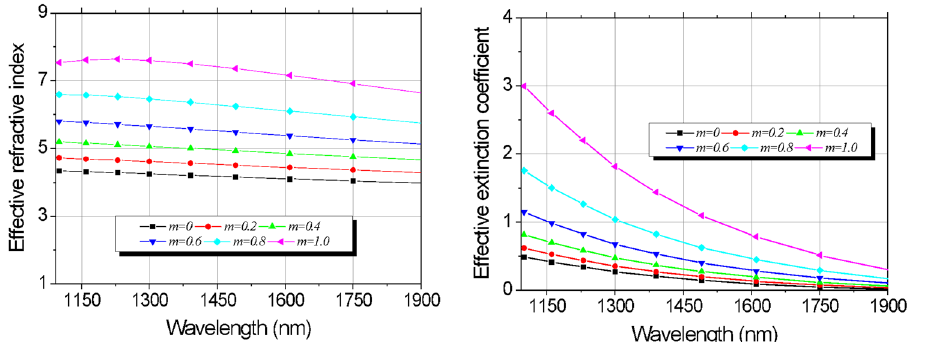
Figure 2. ( a ) Refractive index and; ( b ) extinction coefficient of the GeTe using Eq.